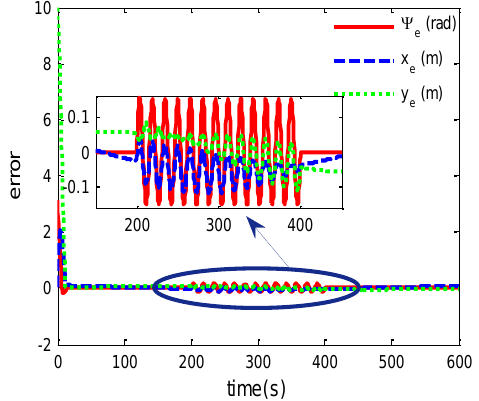
Figure 4. Position and direction errors of AUVs using the proposed controller.